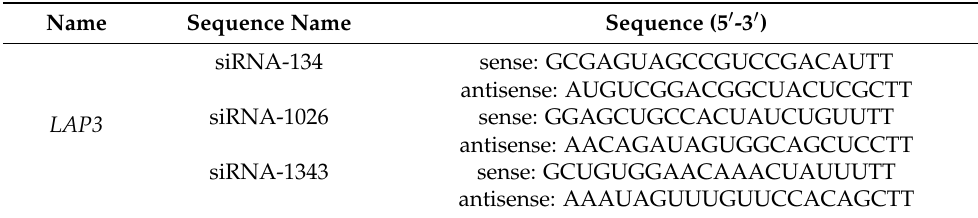
Table 2. Sequence information of RNA